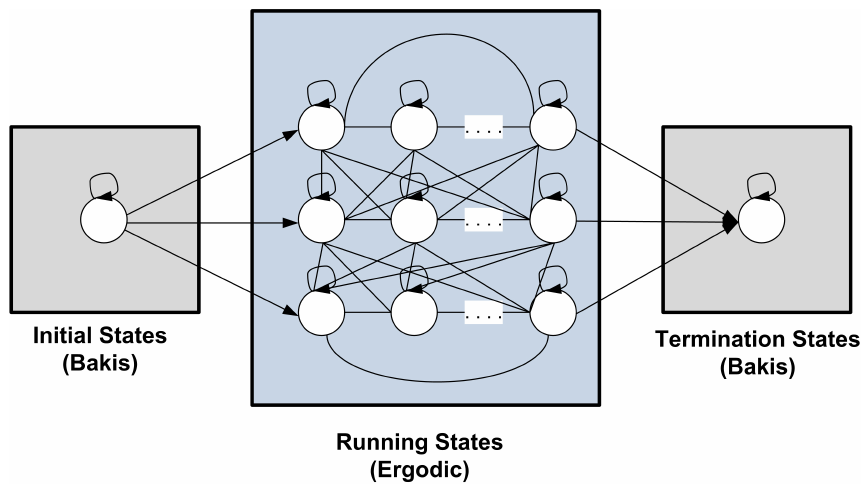
Figure 2. The proposed program behavior-aware HMM topology in HM 3 alD .